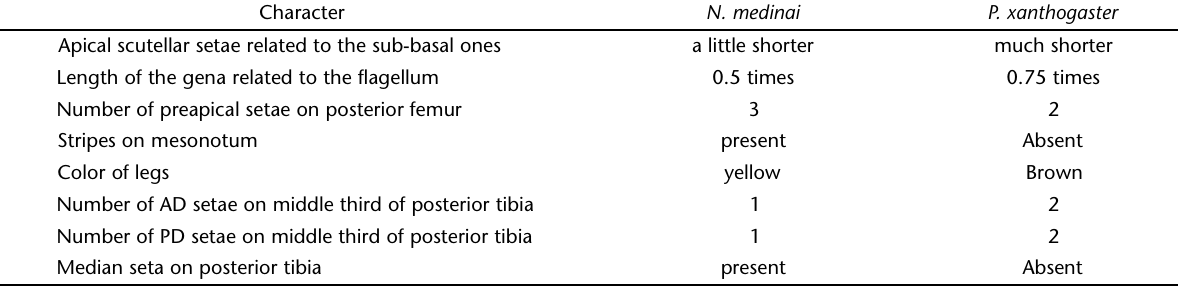
Table II. Historical synopsis of the different taxonomic concepts of N. medinai , N. cavalata and P. xanthogaster . S NYDER